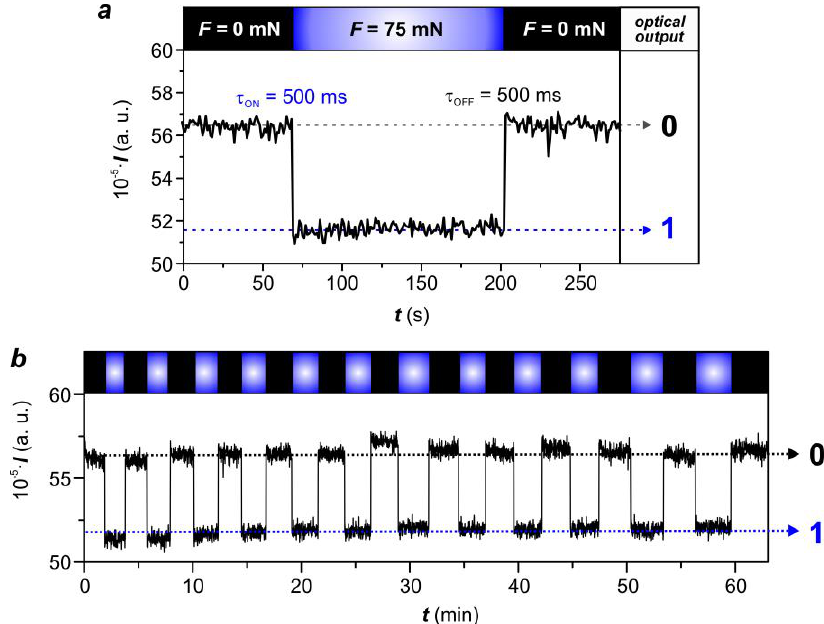
Figure 7. Time-resolved mechanofluorescence experiment for LSCE EM4_CBZN6_10 [19]. (Copyright from Wiley-VCH Verlag GmbH & Co. KGaA 2015).